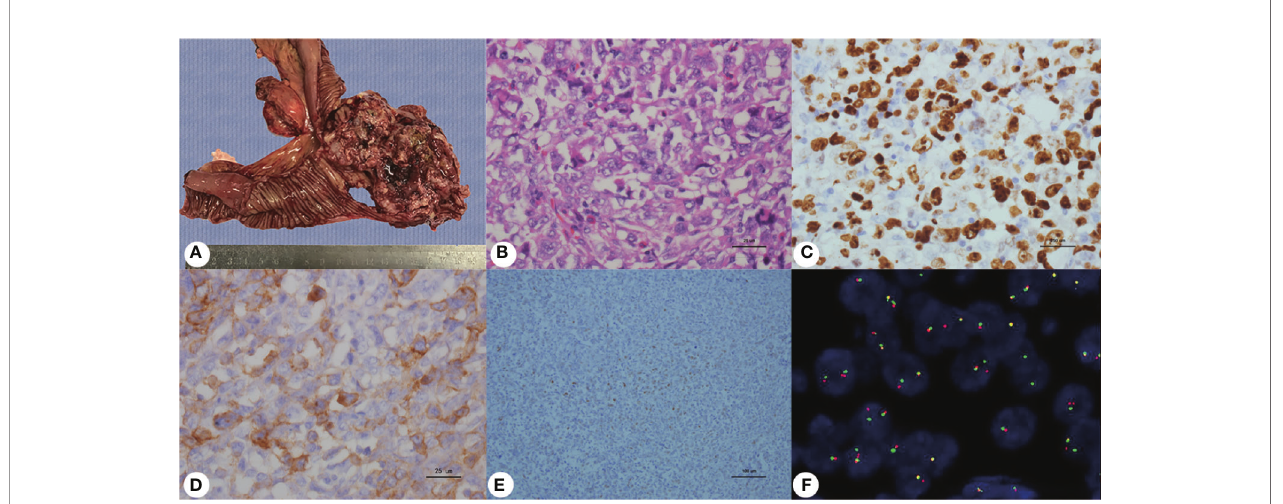
FIGURE 3 | (A) Gross pathology revealed an ileum tumor specimen with brittle texture and multiple ulcerations on the surface; (B) H&E staining revealed small round blue cells; ×40. (C – E) Immunohistochemistry showed positive Ki67, CD99 and Fli-1 staining; ×40. (F) Molecular analysis revealed positive EWSR1 fusion